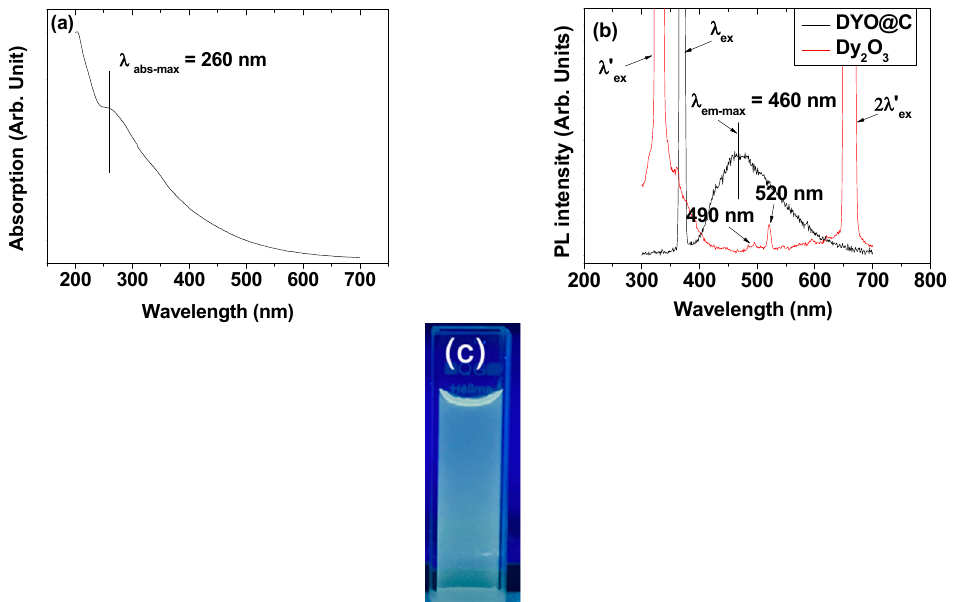
Figure 9. ( a ) UV-visible absorption spectrum of the aqueous DYO@C nanoparticle solution sample; ( b ) photoluminescent (PL) spectra of the aqueous DYO@C and Dy 2 O 3 nanoparticle solution samples ( λ ex = 370 nm, λ ’ ex = 330 nm, 490 nm = Dy: 4 F 9/2 → 6 H 15/2 , and 520 nm = Dy: 4 I 15/2 → 6 H 13/2 ); and ( c ) photograph of the solution sample under 365 nm UV irradiation, showing blue-green fluorescence.